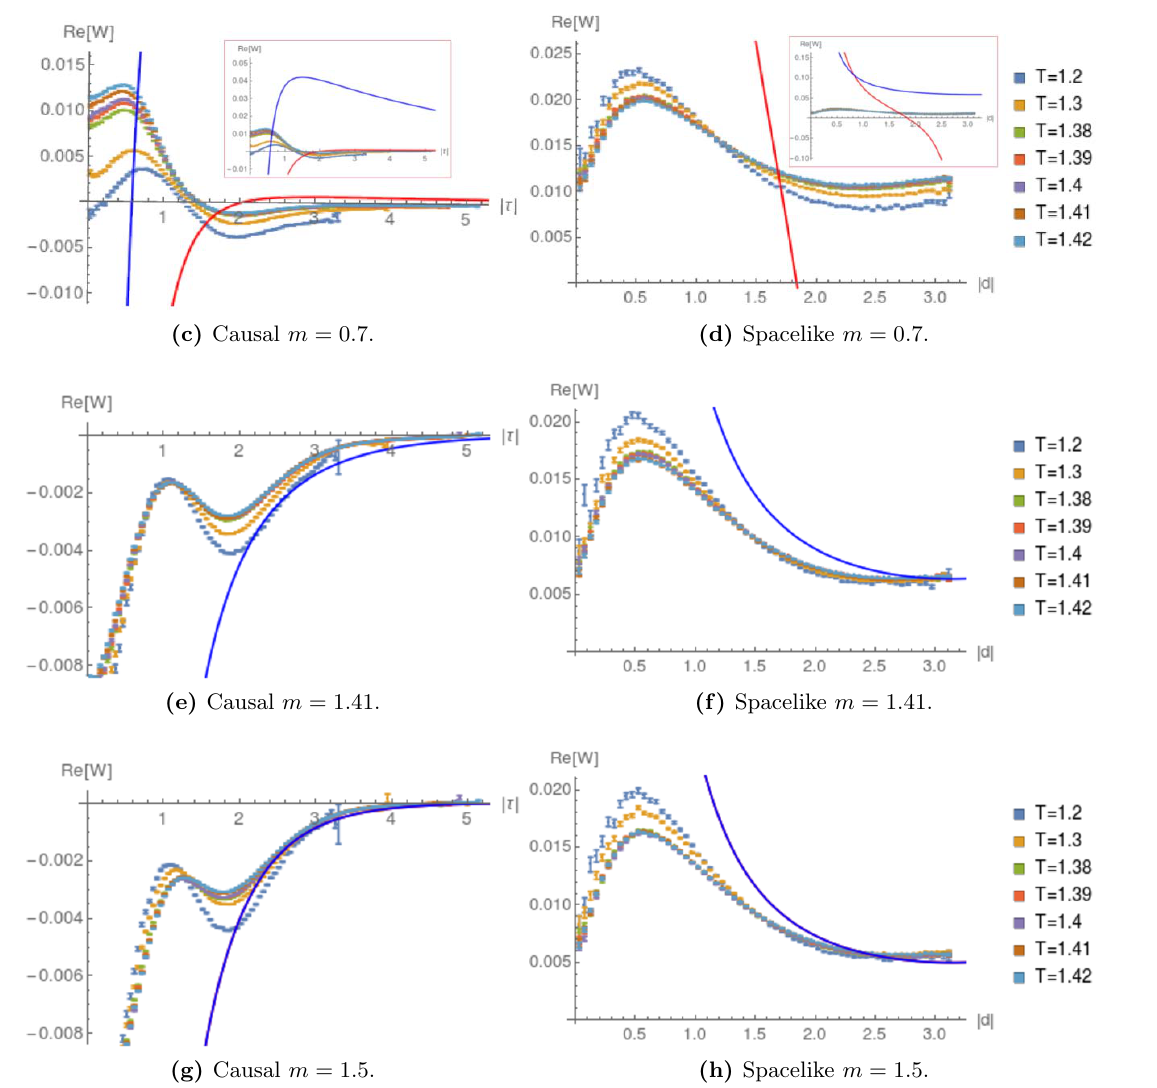
Figure 24. Re[ W ] vs. geodesic distance with varying T for various m at ρ = 9, in 4d de SJ Sitter. The red and blue curves represent the corresponding continuum α - and Euclidean two-point functions respectively. The inset figures represent the zoomed-out versions. In (e)-(f), for m = √ 2 there is no corresponding α -vacuum, and in (g)-(h) the α -vacuum and Euclidean vacuum